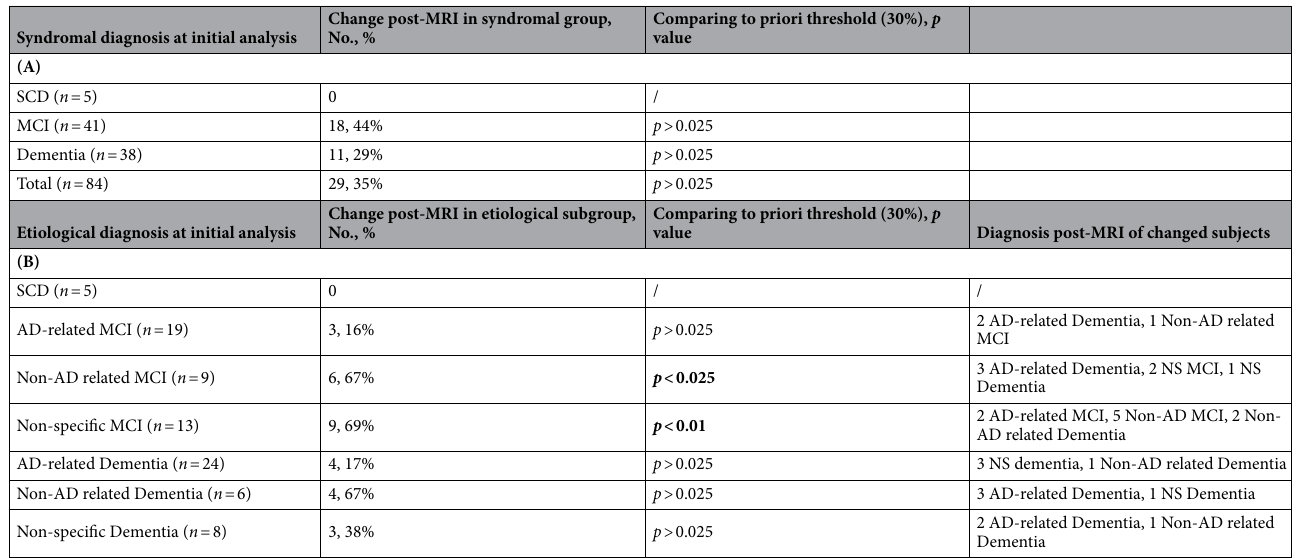
Table 5. Change in diagnosis following MRI. Significant values are in [bold]. (A) in the syndromal group, (B) in the etiological subgroup. NS Non-specific.